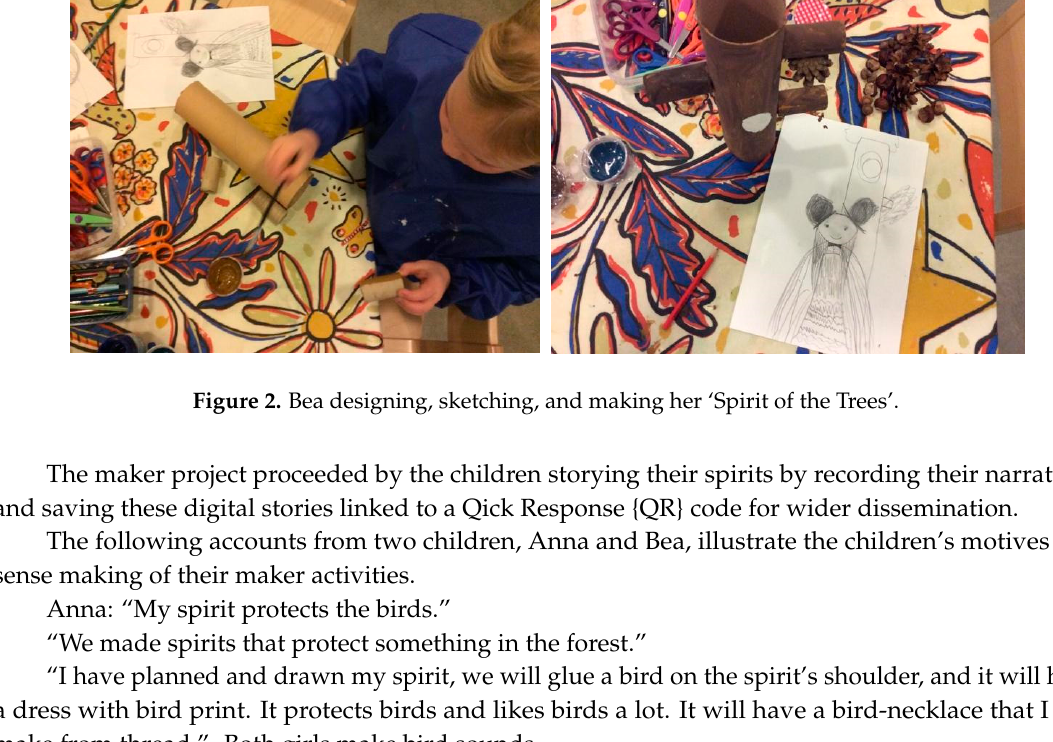
Figure 2. Bea designing, sketching, and making her ‘Spirit of the Trees’.